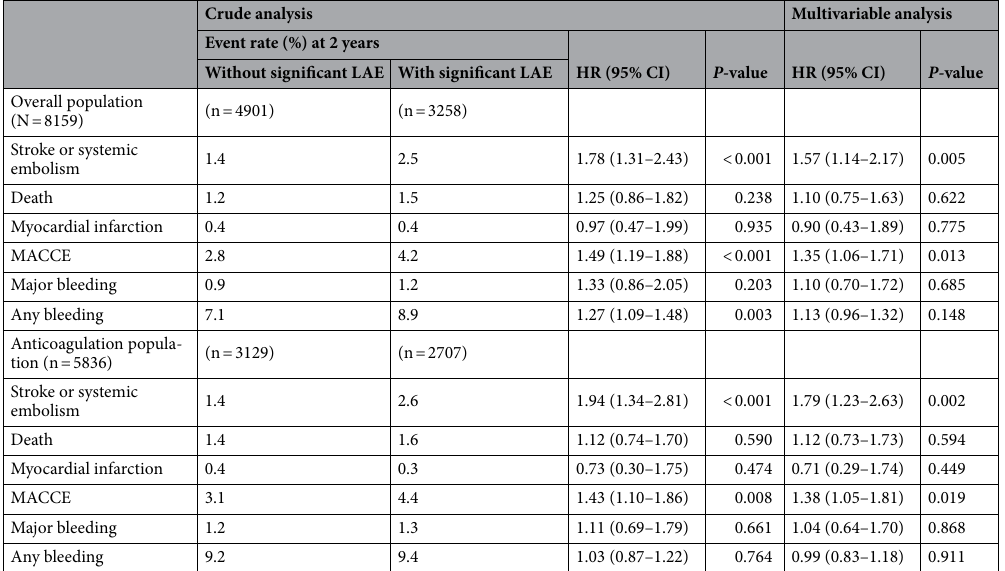
Table 4. Prognostic implication of significant left atrial enlargement on clinical outcomes. MACCE major adverse cardiac and cerebrovascular event. *Adjusted for age, sex, hypertension, diabetes, previous stroke, heart failure, and vascular